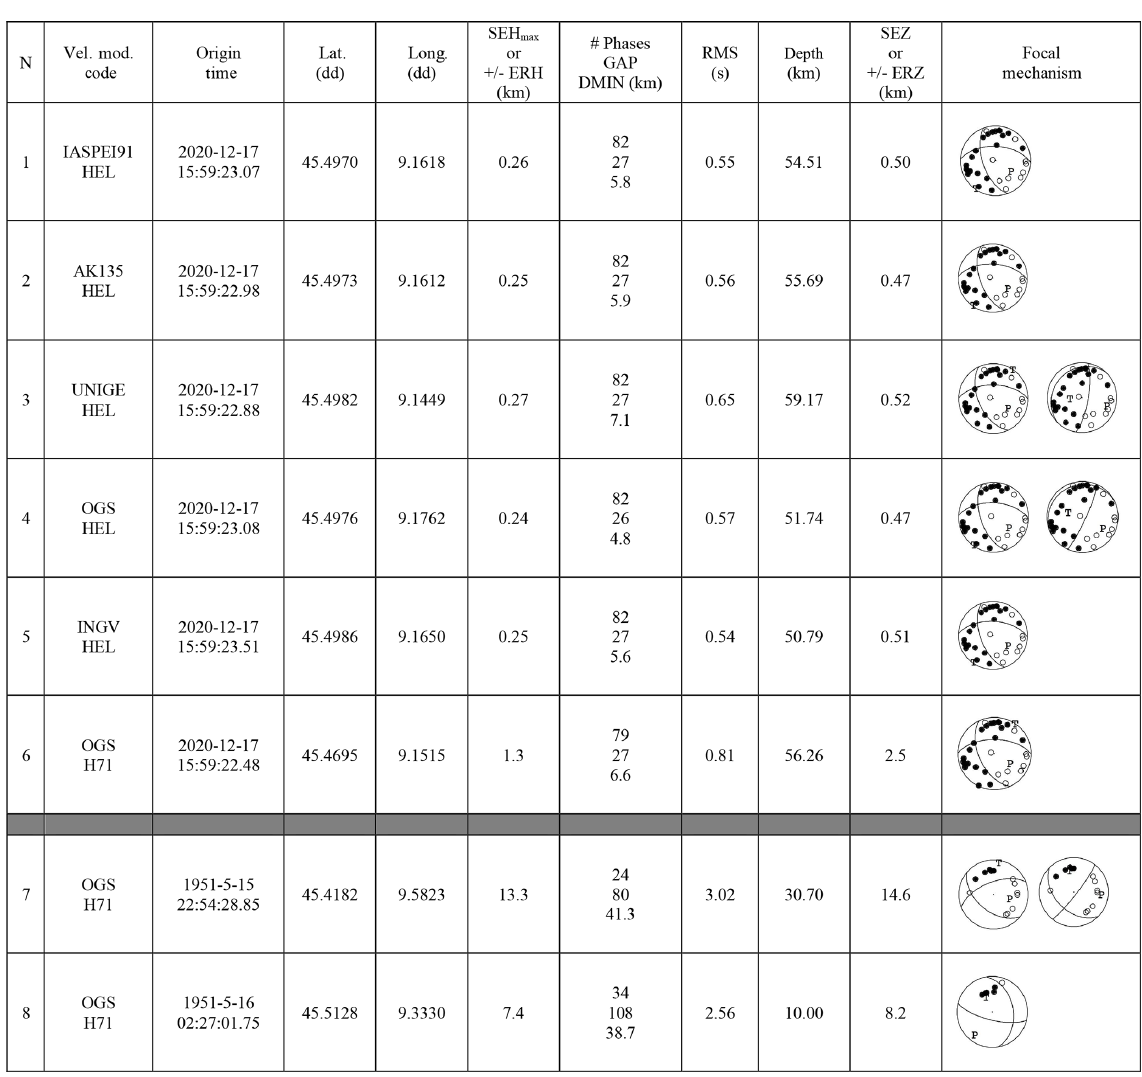
Table 3. (1–6) Hypocentral parameters of the 17 December 2020 Milan earthquake based on different velocity models and location codes; (7–8) hypocentral parameters of the two 1951 Caviaga events. SEH max /SEZ: (maximum) horizontal and vertical single 68%